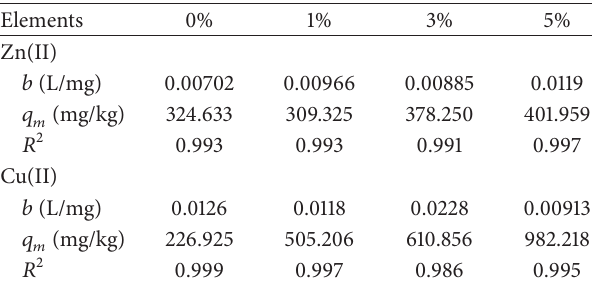
Table 5: The values of isotherm parameters for the modified clay containing